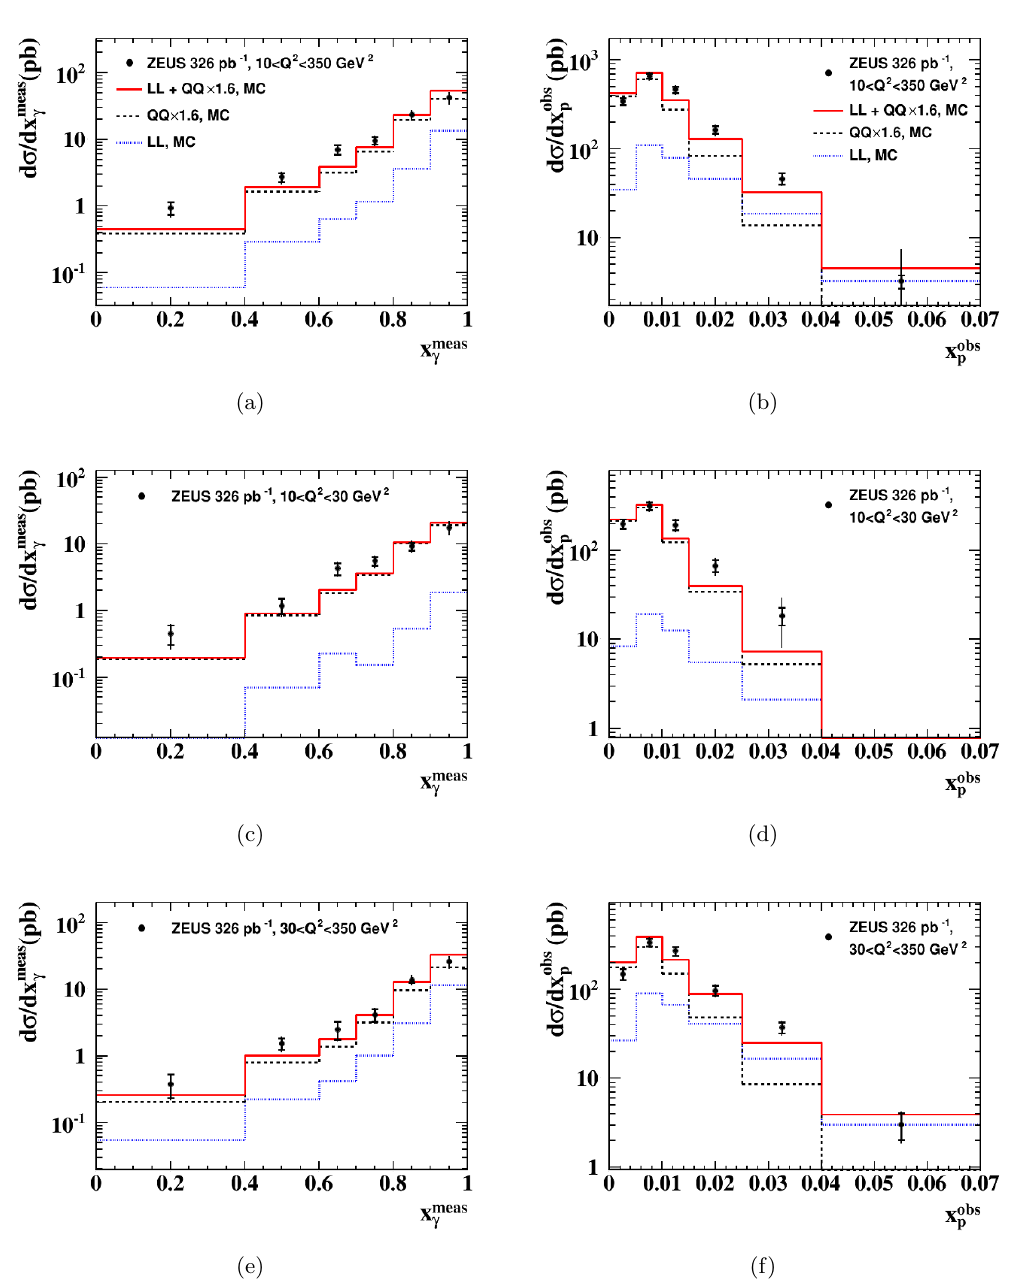
Figure 6 . Di(cid:11)erential cross sections in (a, c, e) x meas 350 GeV 2 , (c, d) 10 < Q 2 < 30 GeV 2 , and (e, f) 30 < Q 2 < 350 GeV 2 . The distributions are as shown in (cid:12)gures 3{5 but with logarithmic vertical scale.